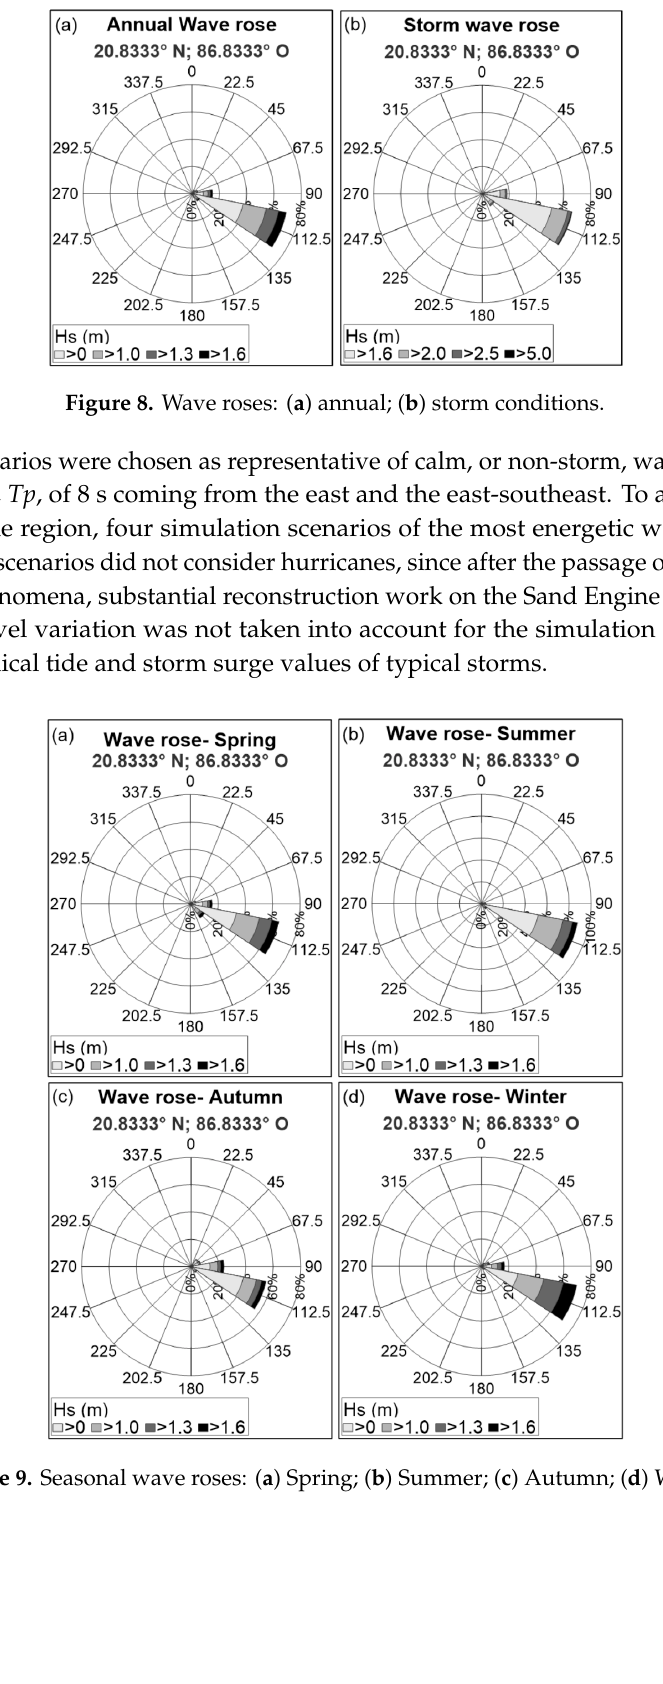
Figure 10. Joint probaility Hs, Tp, Dir: ( a ) Hs/Tp; ( b ) Hs/Dir. Table 1. Definition of the numerical simulation wave scenarios. Scenario